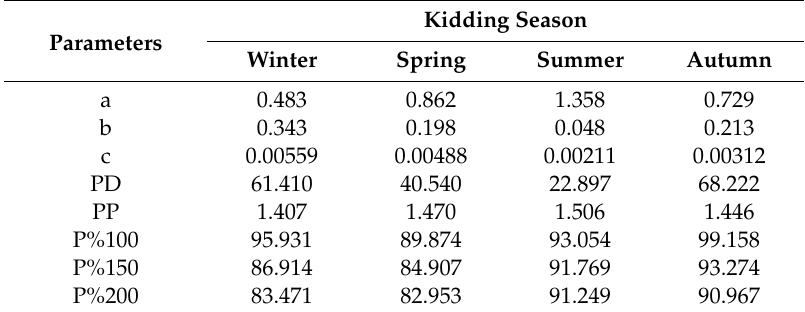
Table 7. Average values across kidding season levels for the parameters of the lactation curve (a, b and c); peak day (PD); peak production (PP); persistence percentage at 100 (P%100), 150 (P%150) and 200 days